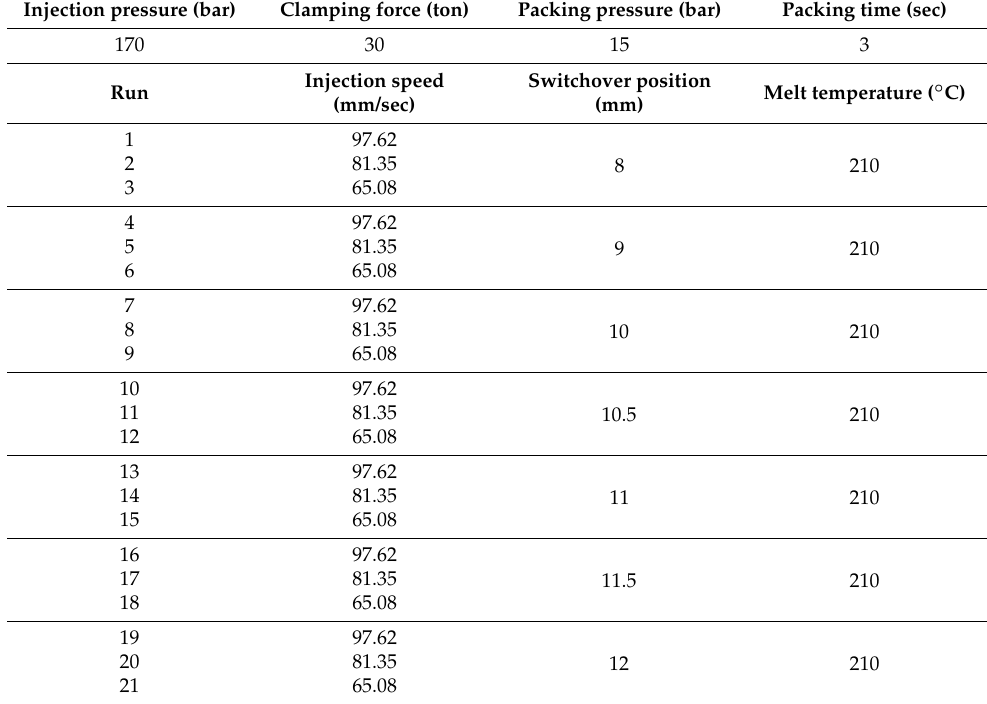
Table 7. Experiment parameters for three seconds of packing time.